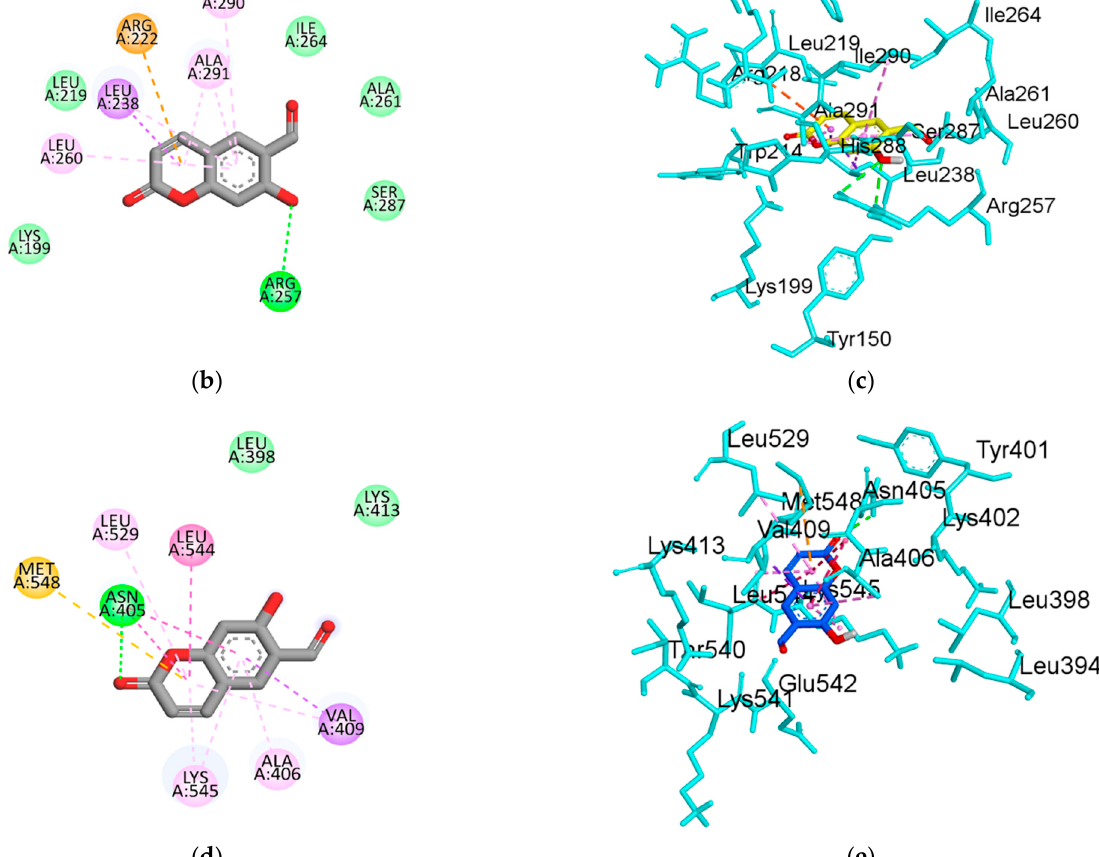
Figure 5. Molecular docking model for human serum albumin (HSA) inhibition by 6-formyl um- belliferone (6-FU). ( a ) Overlapping of the docked 6-FU (yellow) in subdomain IIA (binding site I) of HSA and 6-FU (red) in subdomain IIIA (binding site II) of HSA (PDB: 1AO6). The HSA domains are colored blue for domain I, cyan for domain II, and green for domain III. 2D interactions of 6-FU inside subdomain IIA of HSA ( b ) and 3D interactions and major binding interactions between the inhibitors and subdomain IIA of HSA ( c ). 2D interactions of 6-FU inside subdomain IIIA of HSA ( d ) and 3D interactions and major binding interactions between the inhibitors and subdomain IIIA of HSA ( e ). The interactions are represented in green (conventional hydrogen bonding), pink ( π -alkyl interactions), orange ( π -cation), purple ( π -sigma), dark pink (amide- π stacked), and gold accent ( π - sulfur).